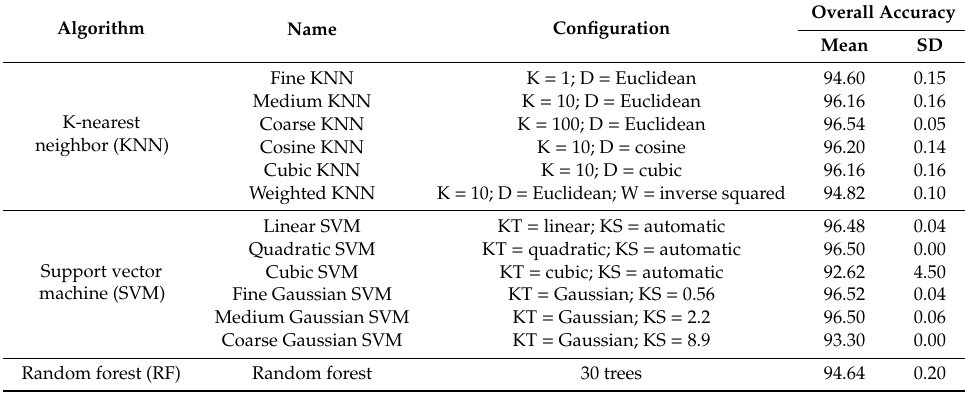
Table A2. Model presets and overall accuracy results using five-fold cross validation by algorithm (i.e., K-nearest neighbor, support vector machine, and random forest models) for the subtidal zone for the contemporary habitat model development for Dauphin Island, Alabama, USA. D: Distance; K = Number of neighbors; KT: Kernel type; KS: Kernel scale; SD: Standard deviation; and W: Weight.